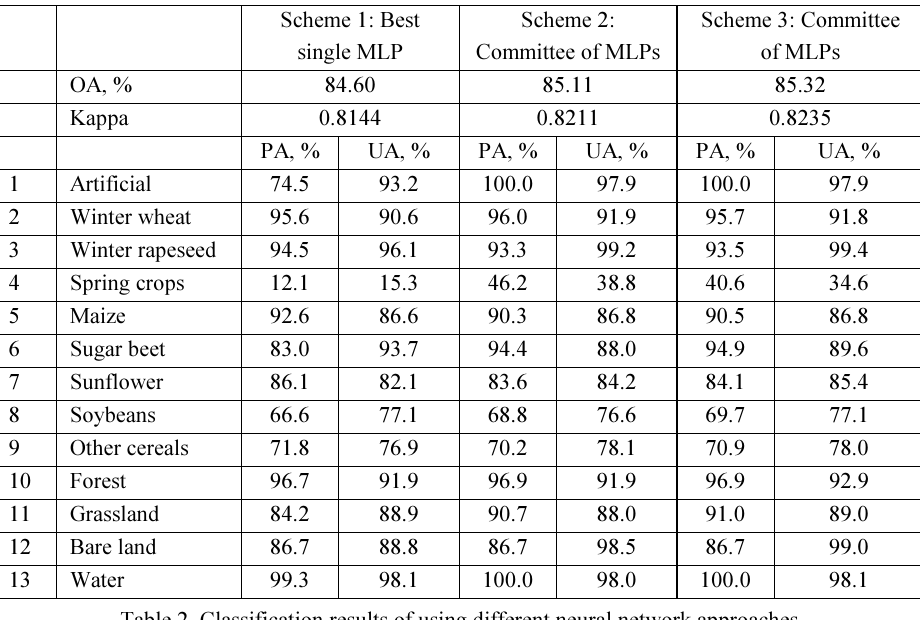
Table 2. Classification results of using different neural network approaches